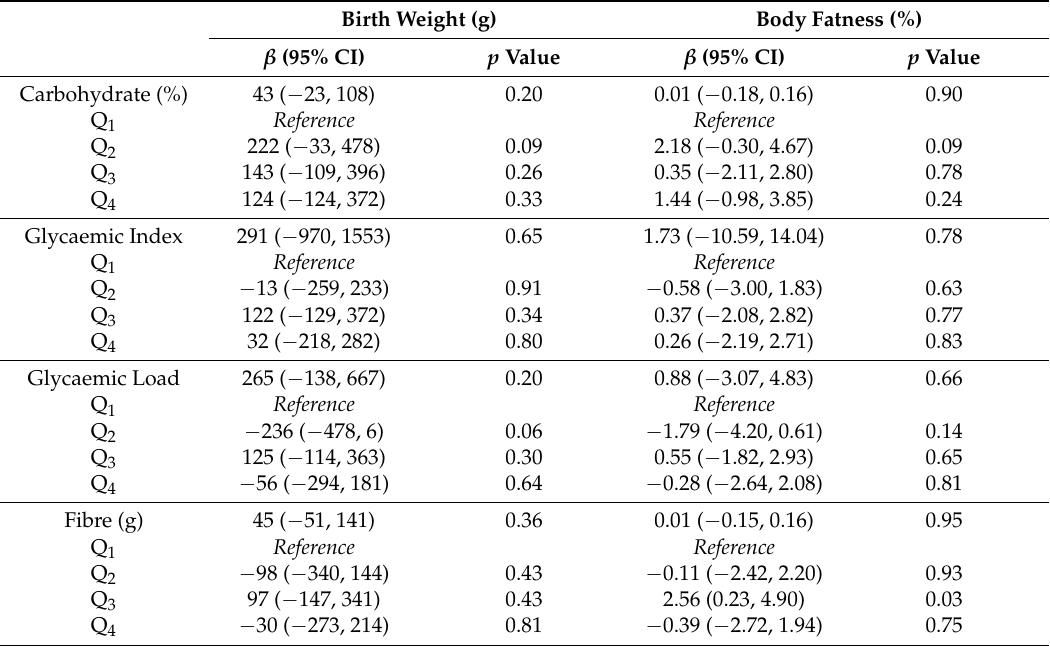
Table 2. Associations between maternal carbohydrate intake, both quantity and quality, with newborn body composition ( n =